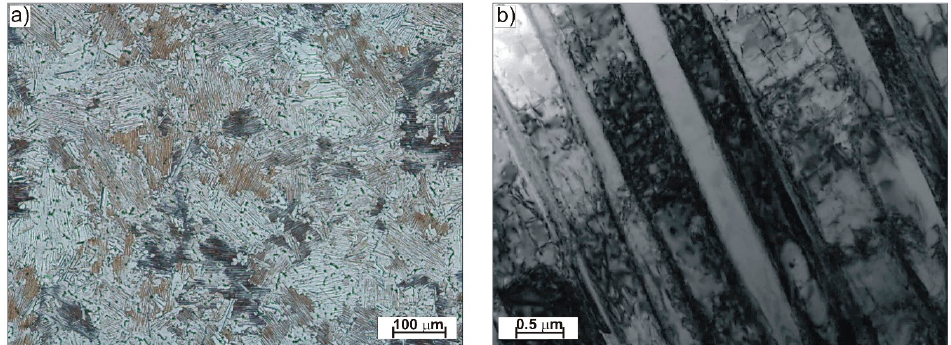
Figure 1. Microstructure of the Ti–45Al–8Nb–0.5(B, C) alloy—initial state: ( a ) LM, ( b ) TEM.